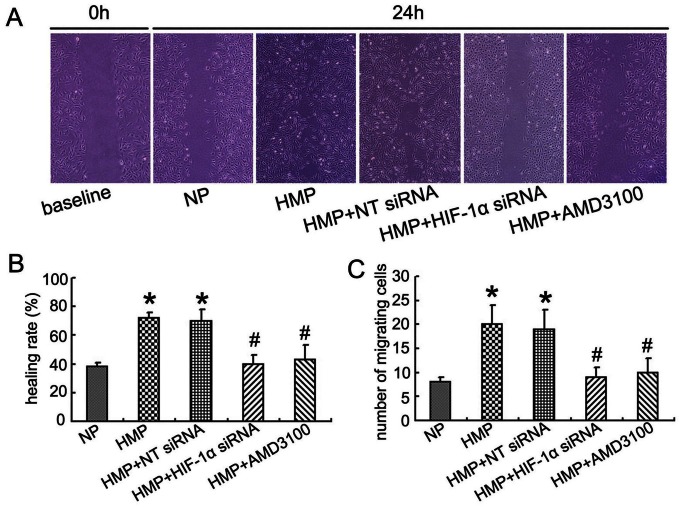
Effect of hypoxia mimetic pretreatment on MSC migration.(A) Scratch-wounding healing assay (magnification ×200). (B) Healing rate of scratch assay. (C) The number of migrating cells in Transwell assay. HMP pretreatment significantly increased the healing rate and in vitro migration ability of MSC, while down-regulation of HIF-1α by siRNA or suppression of CXCR4 by AMD3100 reversed this effect. *P<0.05, vs NP; #P<0.05, vs HMP.